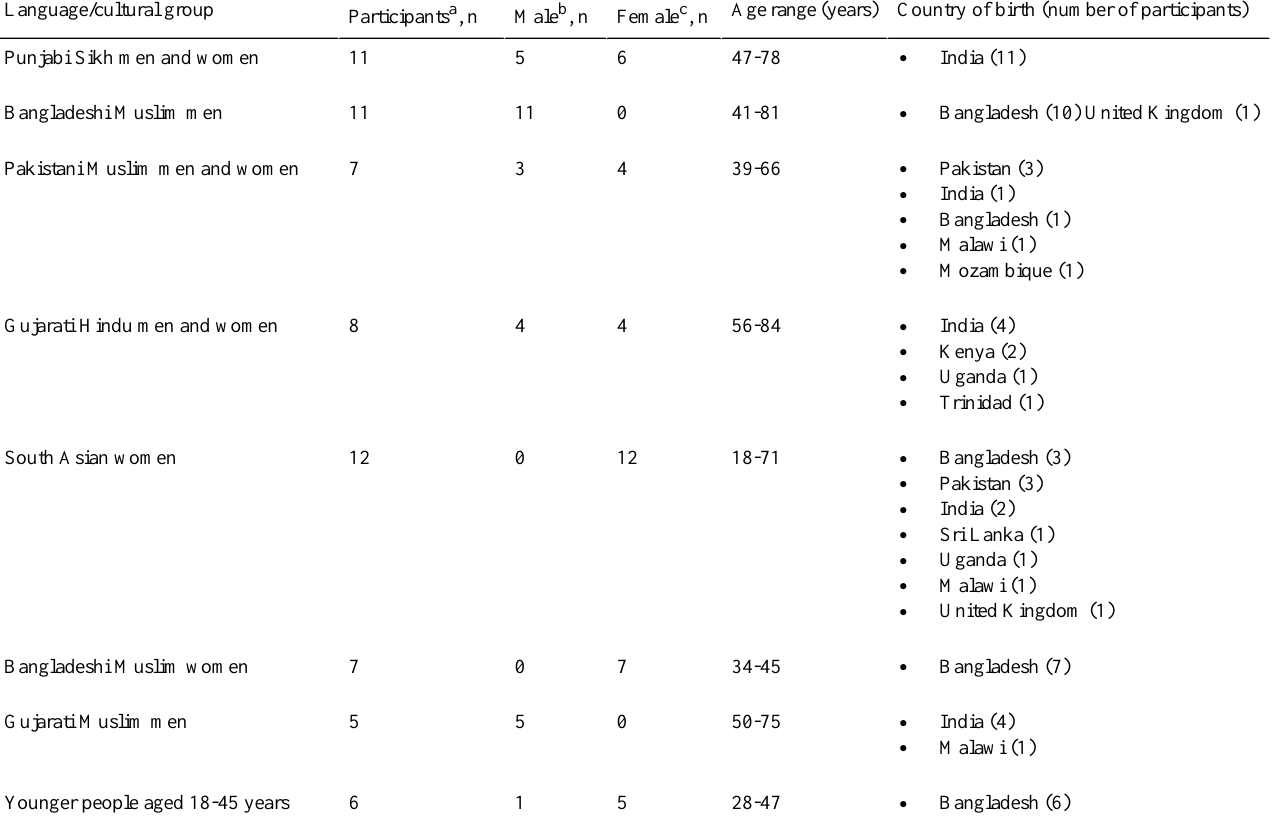
Table 1. Focus group composition and participant demographics